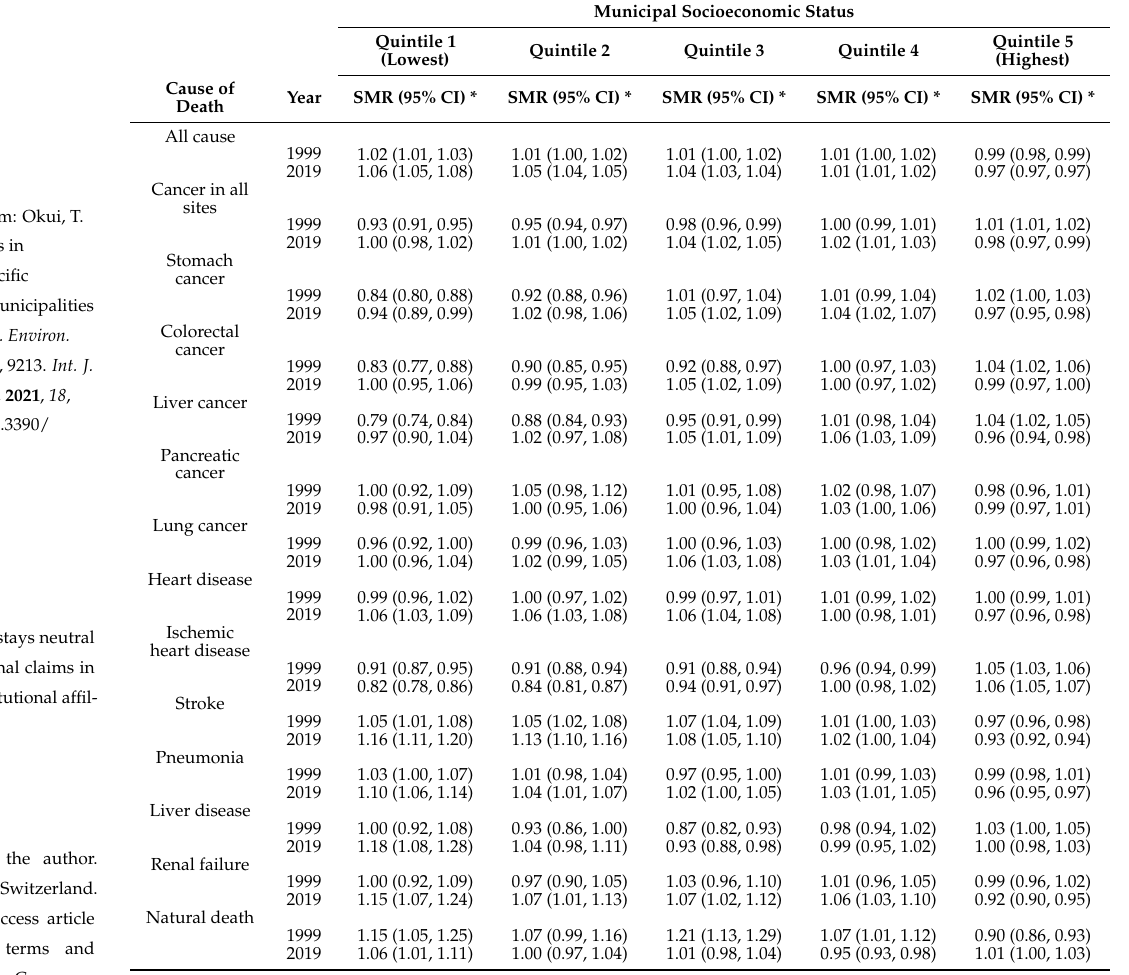
Table 3. SMR for all-cause and each cause of death by municipal SES quintile in 1999 and 2019 for